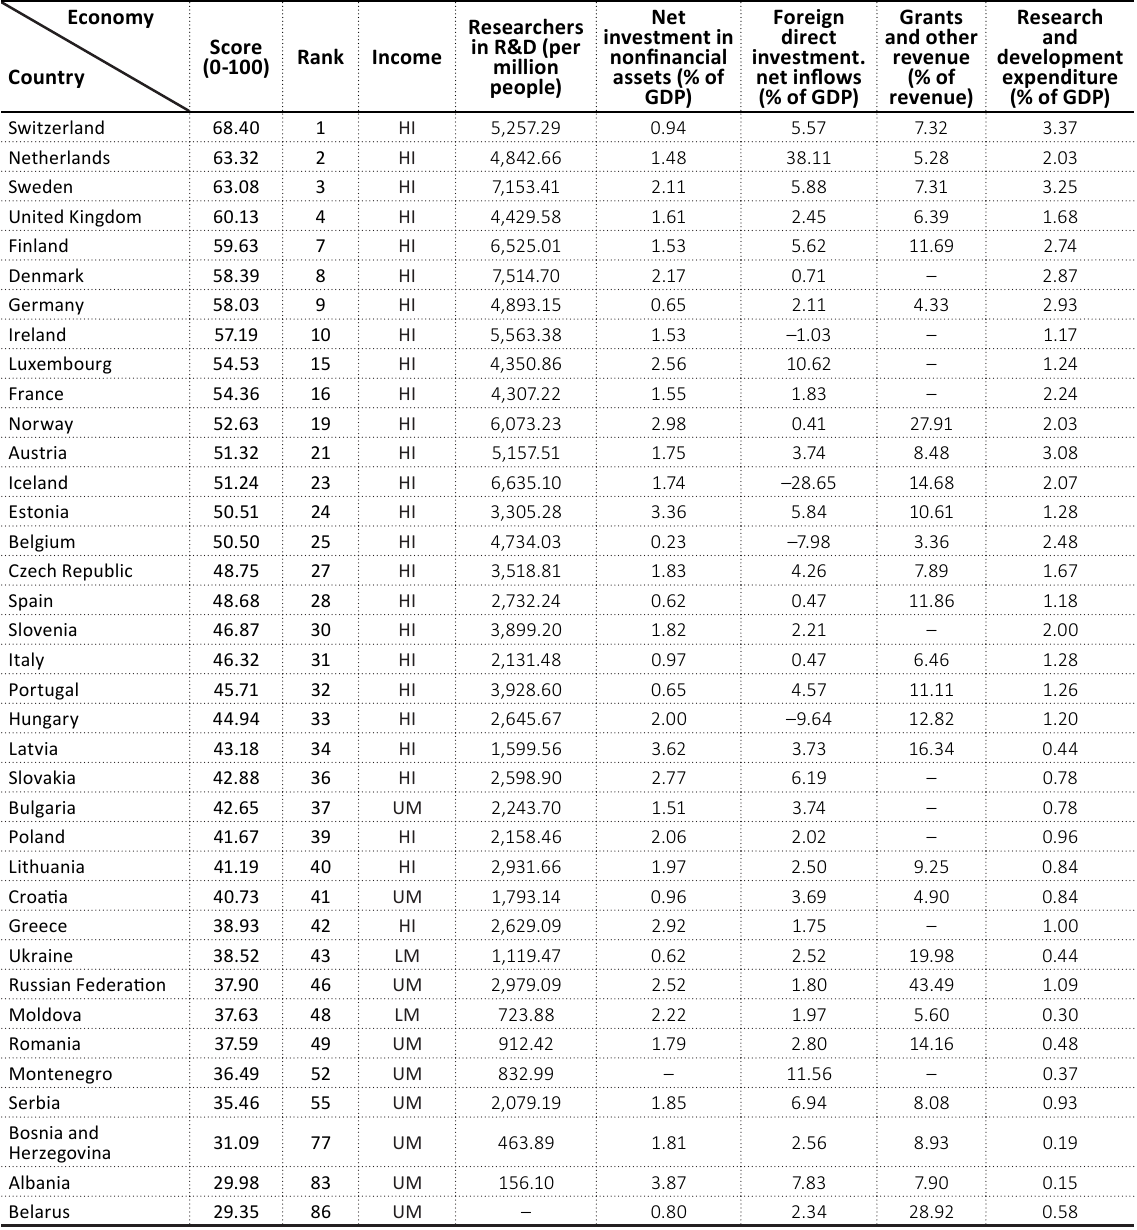
Table 1. Comparison of Global Innovation Index 2018 and financial instruments indicators in European